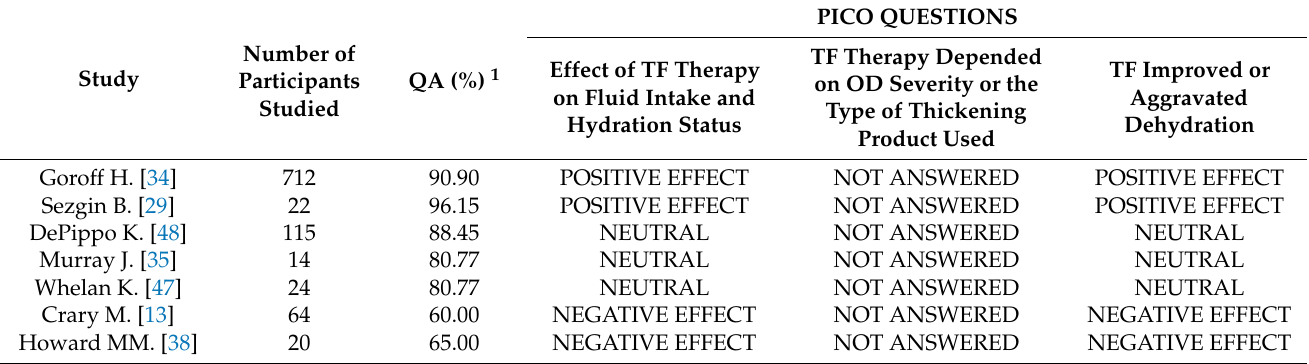
Table 3. Number of participants studied, quality assessment, and answers to PICO questions for